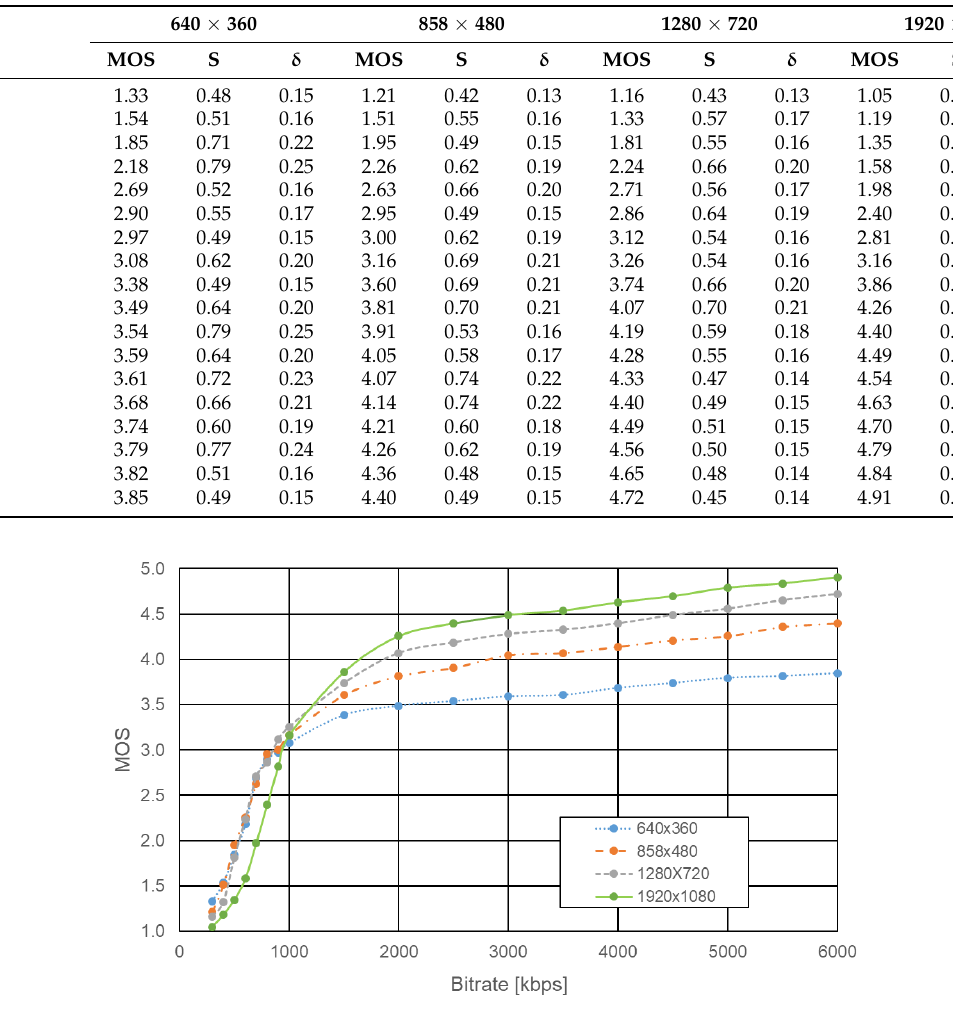
Table 3. Value of the difference in ΔMOS (for H.264 codec) between the results obtained under la- boratory and home conditions.